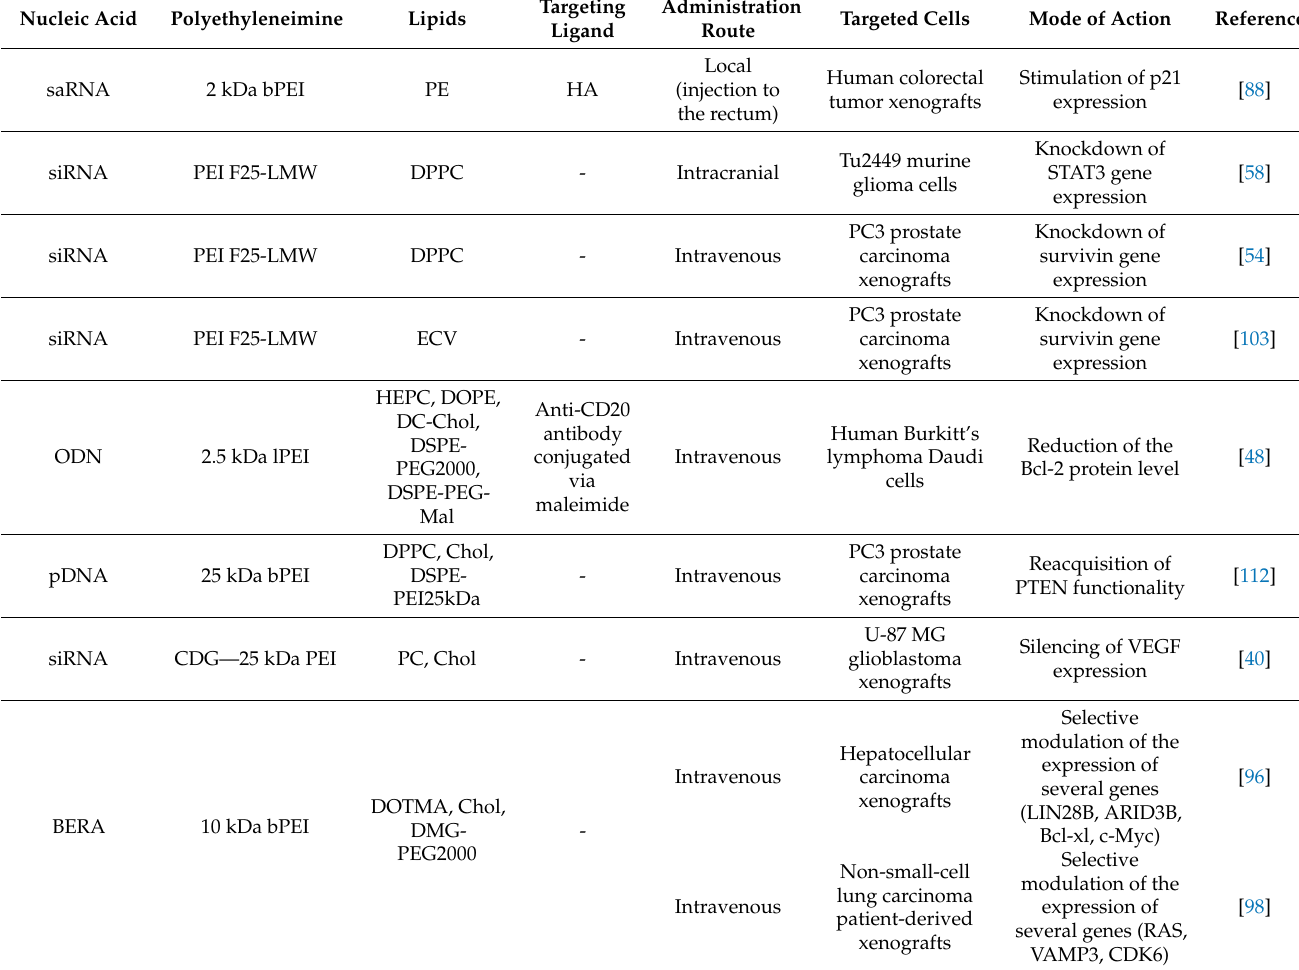
Table 1. Examples of PEI-based lipopolyplexes. BERA—bioengineered non-coding RNA